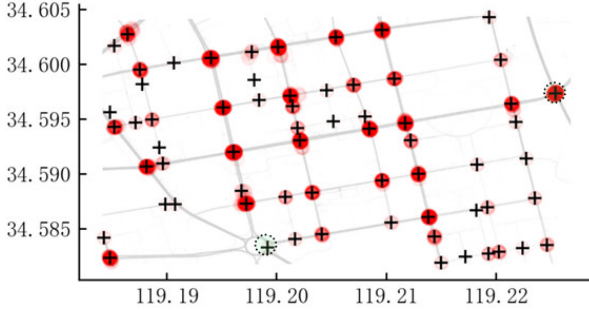
Figure 12. Results of intersection extraction (65).